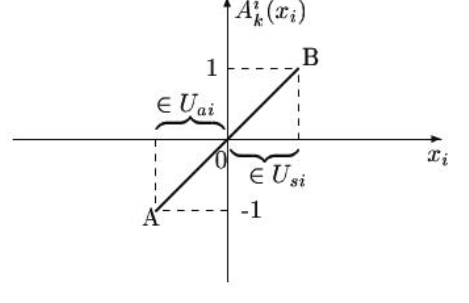
Figure 1 The new membership function for the soft